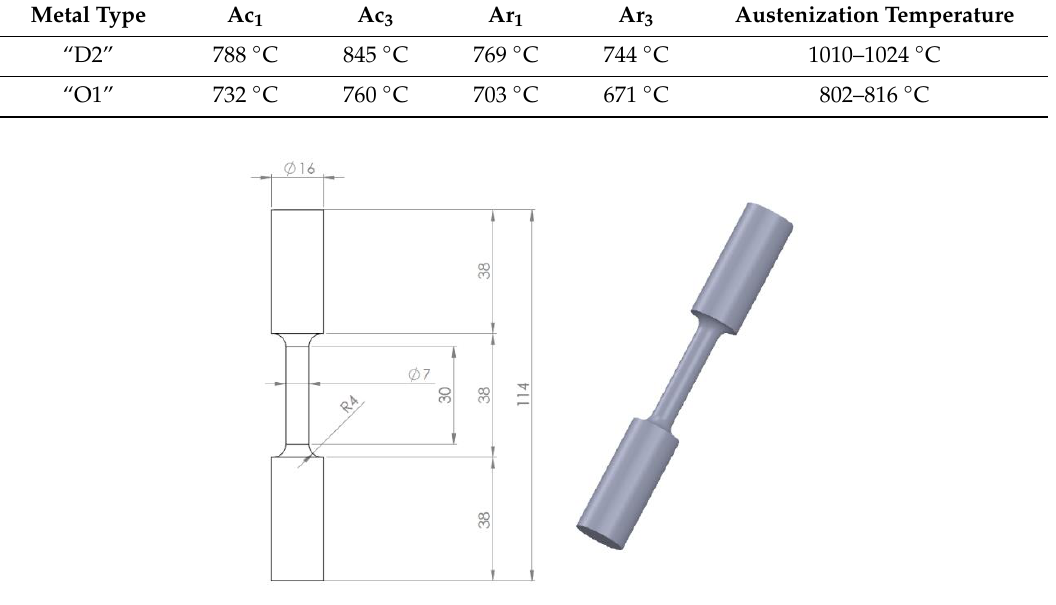
Table 2. Critical and austenization temperatures of “D2” and “O1” tool steels.